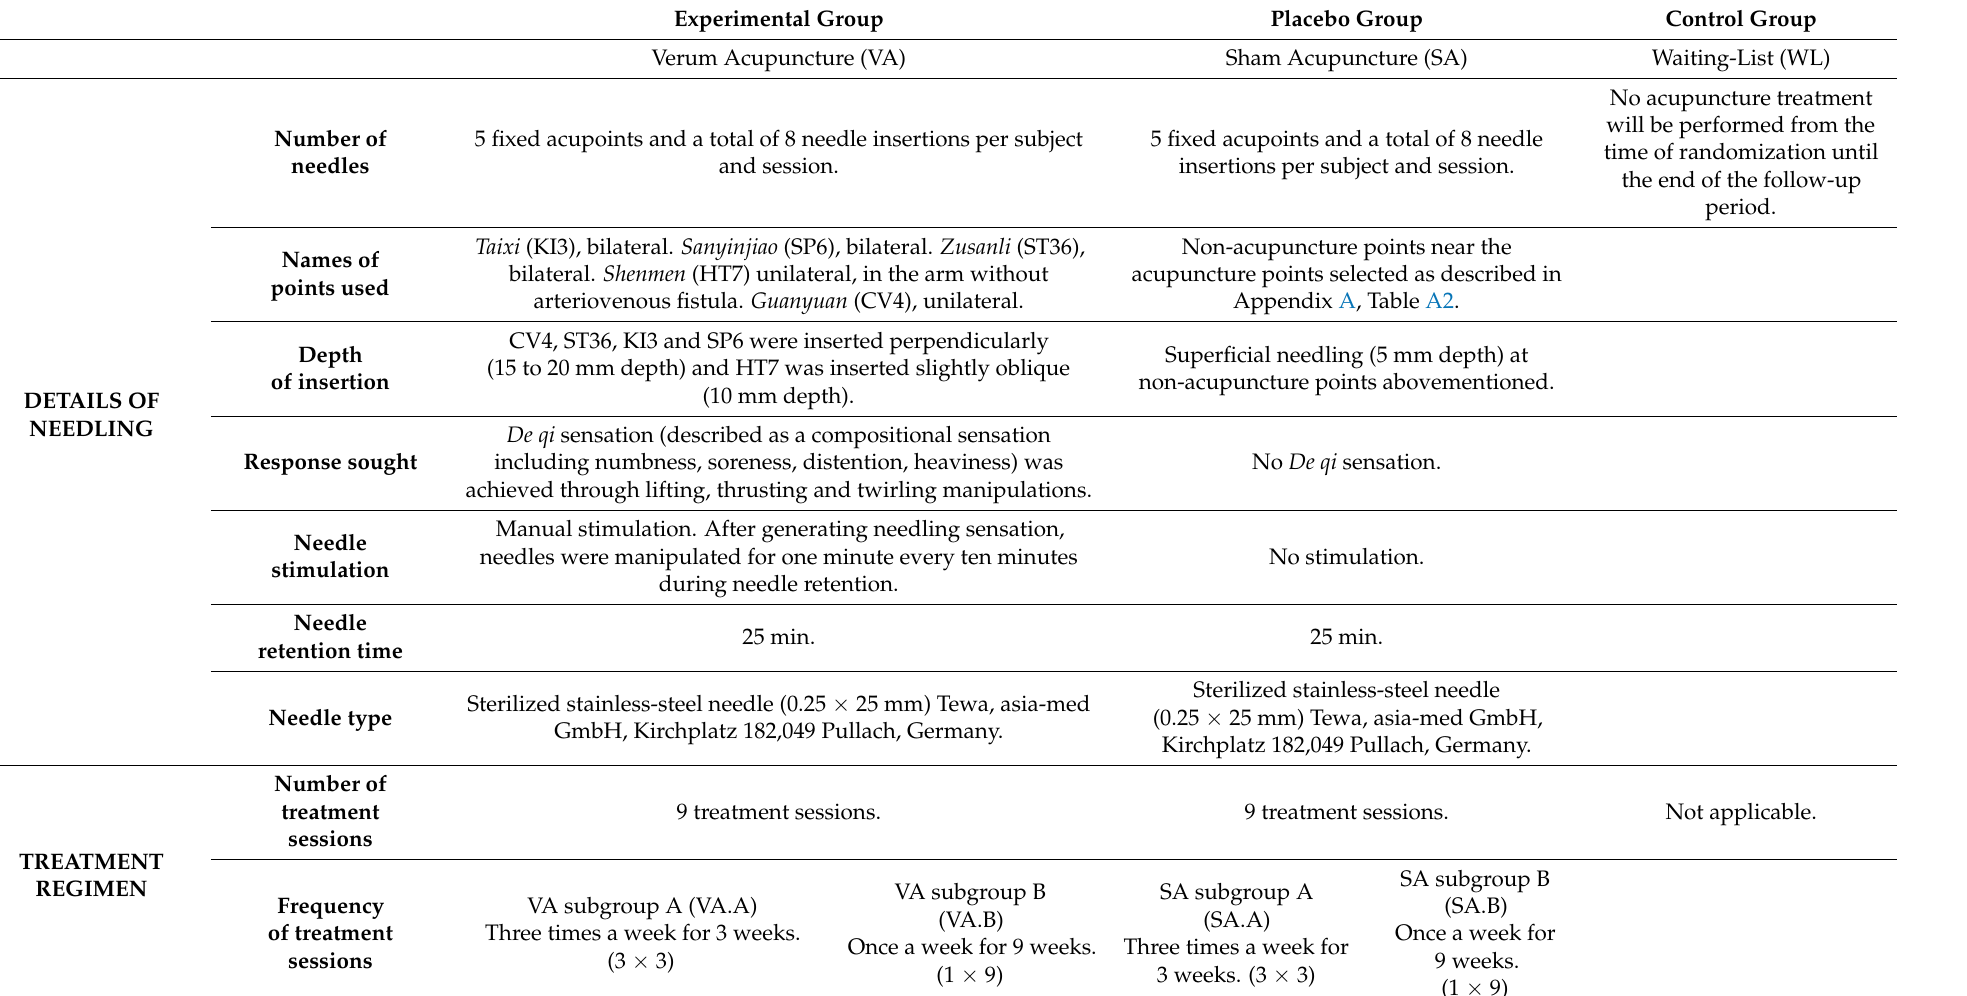
Table 1. Details of needling and treatment regimen.